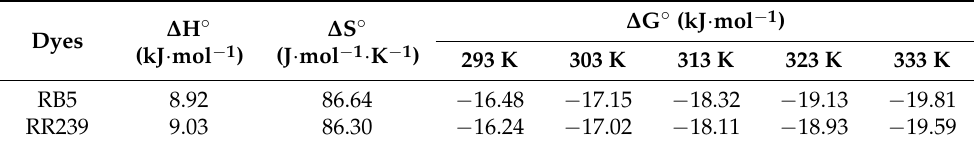
Table 1. Thermodynamic parameters for the adsorption of reactive dyes on CM-ATP. Dyes